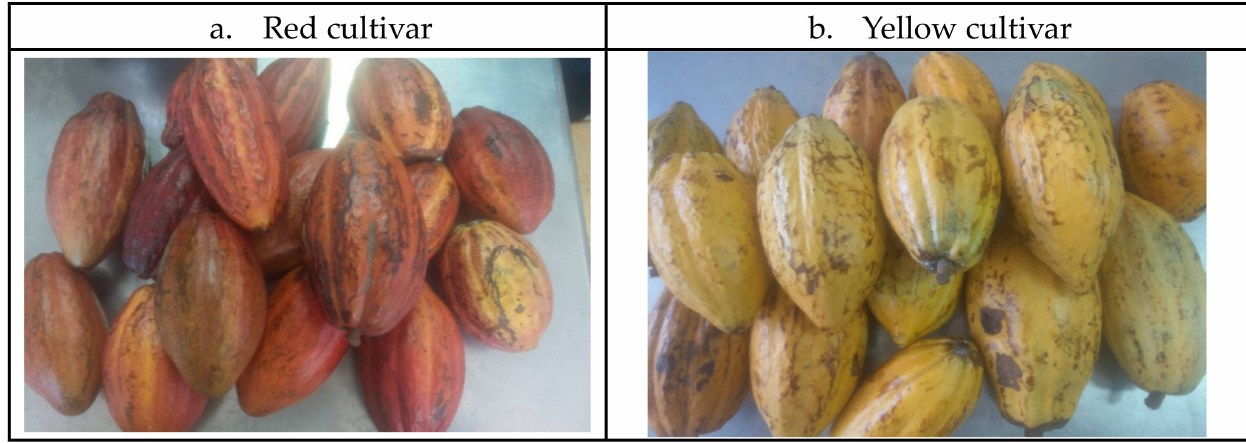
Figure 1. Cocoa pods from two different major cultivars grown in